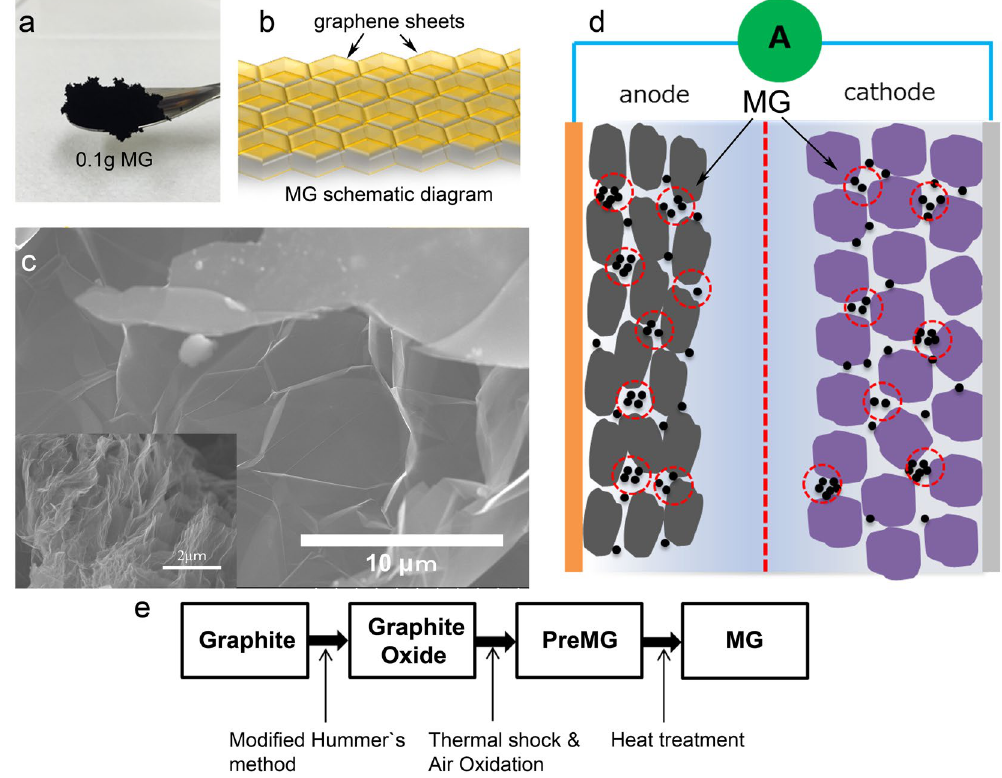
Figure 1. Schematic diagram and the material synthesis process. ( a ) Digital photo of 0.1 g Magic G featuring ultralow density that can even flow in air. ( b ) Schematic diagram of MG with honeycomb-like structure. The wall of each honeycomb cell is made of graphene sheets. ( c ) SEM image of synthesized MG. The honeycomb cell structure graphene sheets can be indicated (MG in low magnification SEM was inserted). ( d ) The MG can be used as an additive for both anode and cathode. Schematic diagram of lithium ion battery consisting of anode, cathode, electrolyte, and separator. ( e ) Synthesis method of Magic G. Natural graphite is used as the raw material and a modified Hummer’s method is used to make graphite into graphite oxide (GO). The GO is then thermal shocked in N 2 to 400 °C in 10 min and mild oxidized in air for 30 min at 500 °C to form the Magic G precursor (PreMG). Finally, the PreMG is heat treated at 1000 °C for 4 h in N 2 to obtain